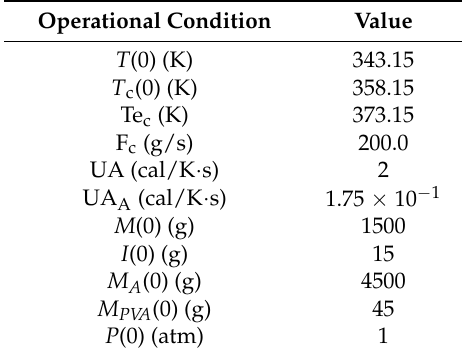
Table 2. Nominal operating conditions used to perform numerical simulations.